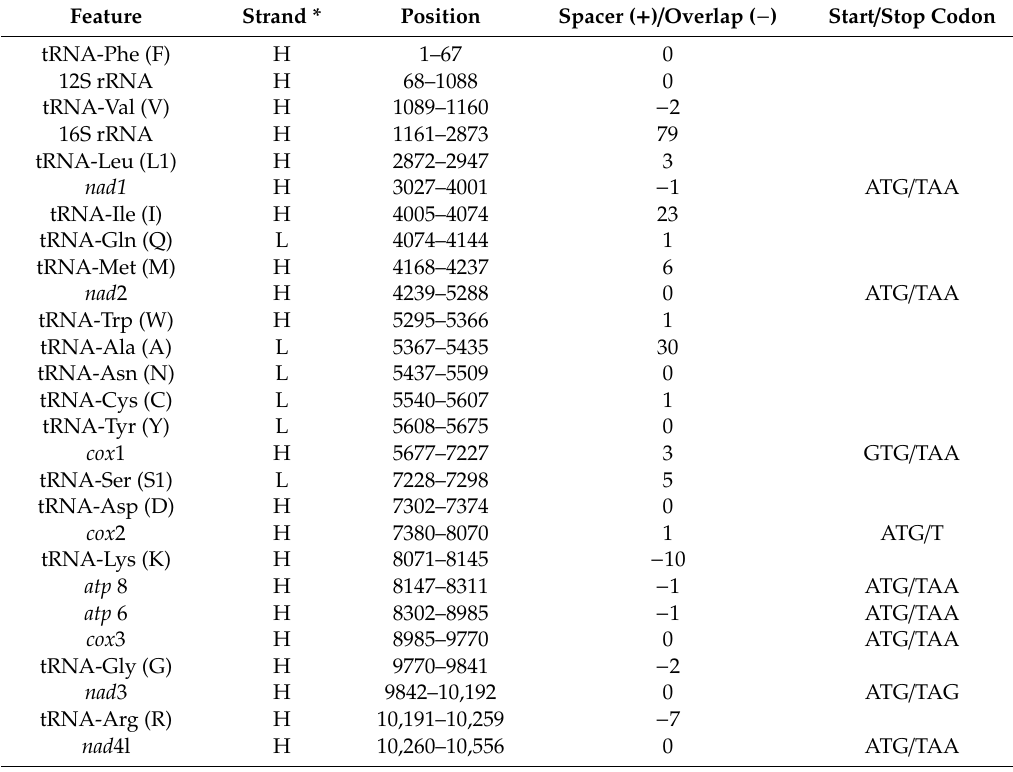
Table 2. Organization constituents of the mitochondrial genome of Cociella crocodilus